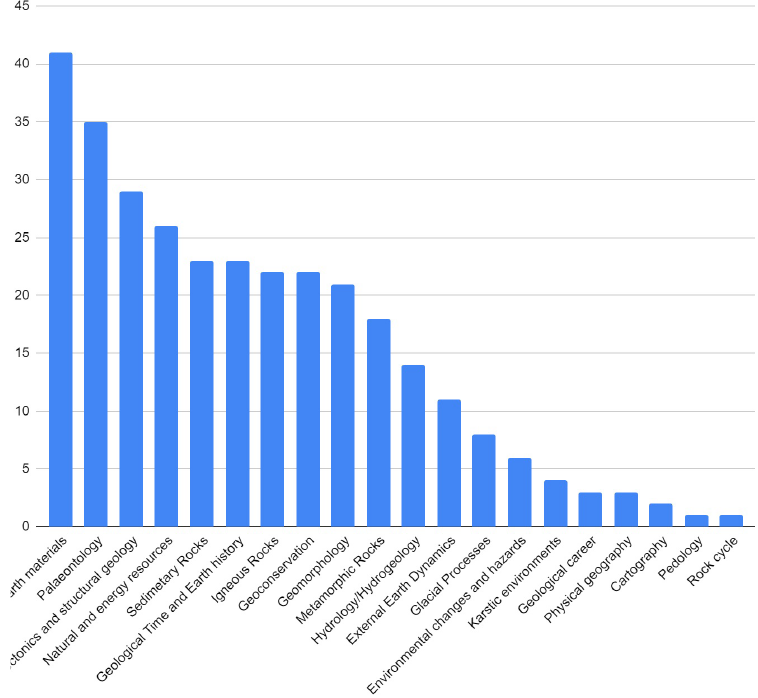
Figure 4. Quantity of geoscientific topics addressed in the educational